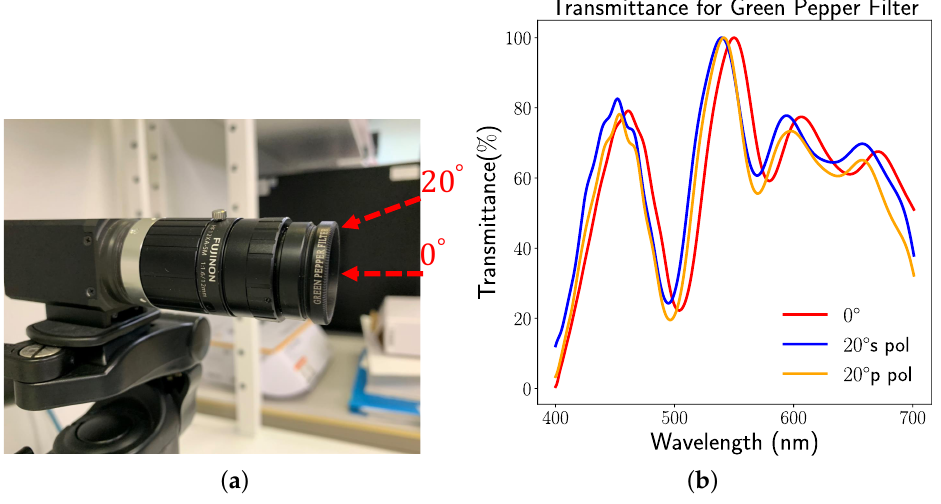
Figure 4. ( a ) The fabricated Green Pepper Filter mounted on a machine vision camera system. ( b ) The transmittance curve of the Green Pepper Filter at different incidence angles.